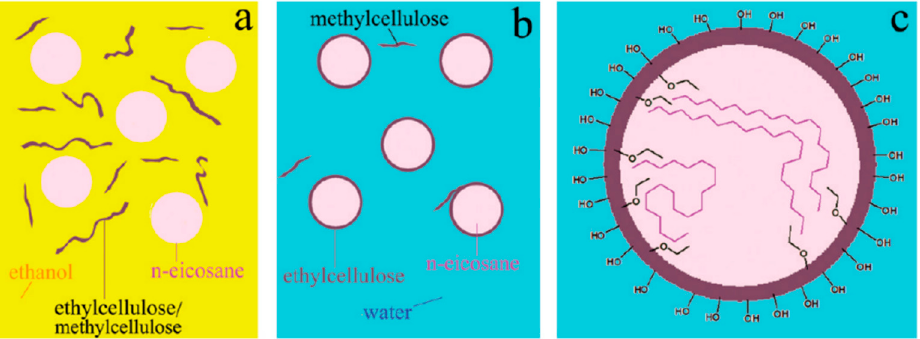
Figure 8. ( a ) Droplets of C20 were suspended in the ethanolic solution of EC and MC; ( b ) The water dispersible C20-encapsulated spheres; ( c ) EC-MC/C20 microcapsules [75].